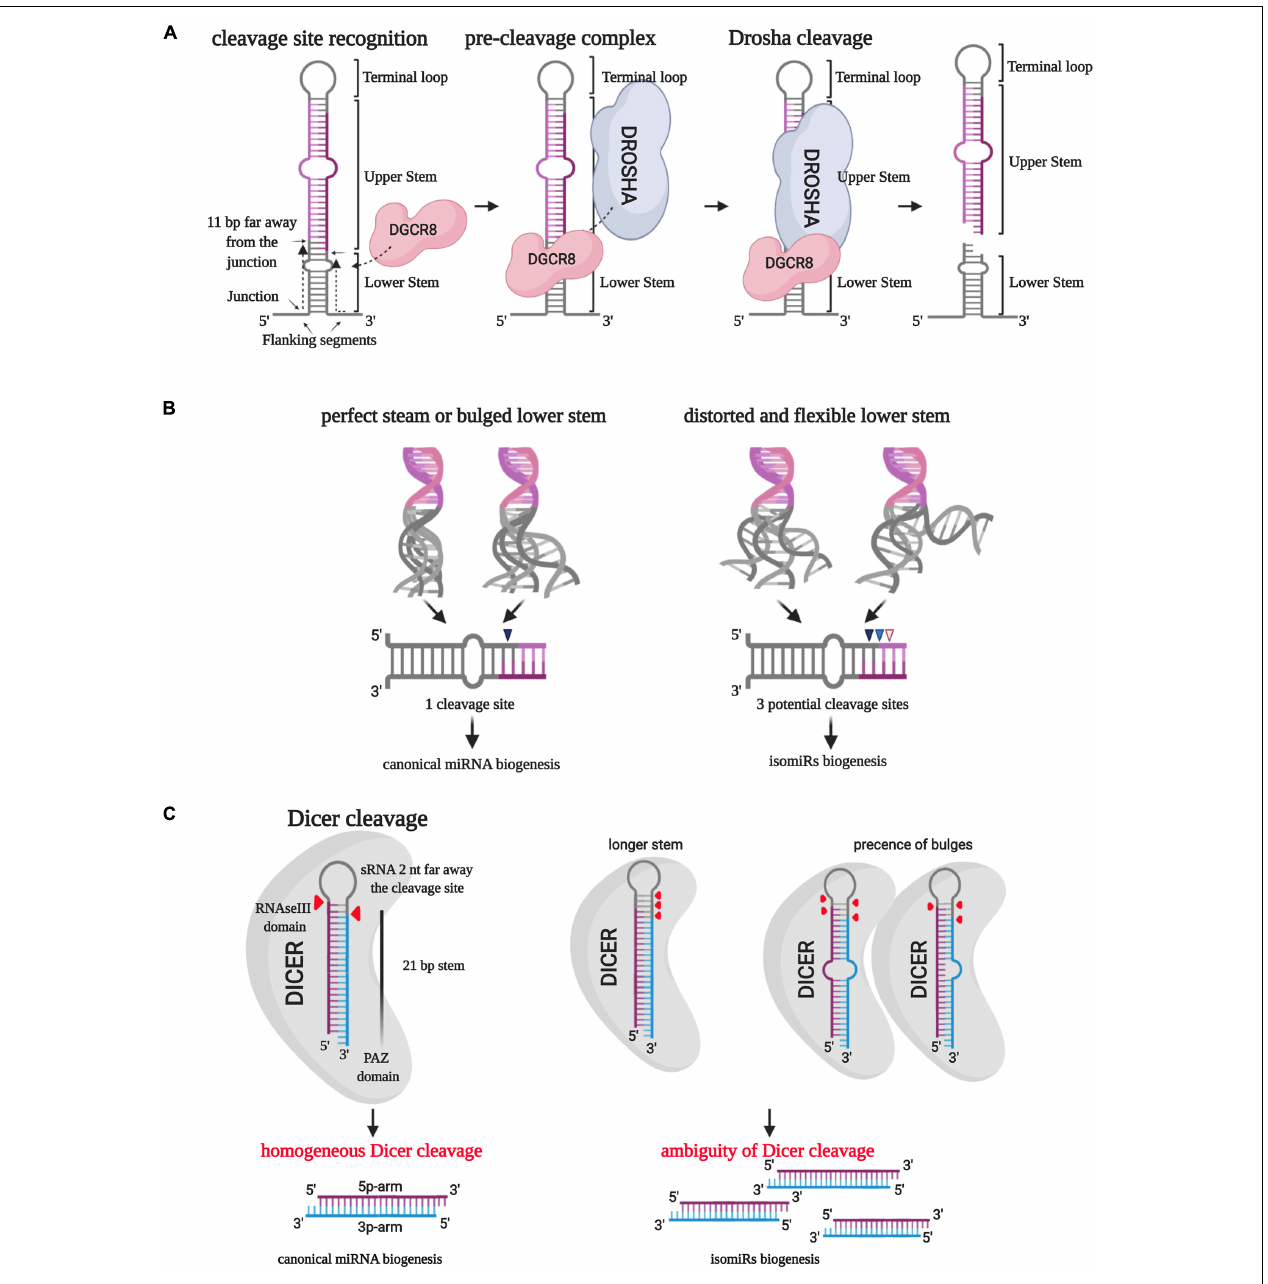
FIGURE 2 | IsomiR biogenesis. (A) The RNAse III DROSHA, aided by DGCR8, processes pri-miRNA in the nucleus and produces the first cut in correspondence of the 5 (cid:48) end of the 5p arm and 3 (cid:48) end of the 3p arm. DGCR8 acts as a molecular meter and identifies the cleavage site 11 bp far away from the junction point between the lower stem and the basal unpaired sequences. (B) The secondary structure of the lower stem of pri-miRNA affects the DROSHA cleavage precision: a perfect or bulged lower stem leads to a homogeneous cleavage site in more than 97% of the cases. On the contrary, a distorted and flexible lower stem creates three potential cleavage sites. (C) The RNase III DICER processes the short hairpin RNA (shRNA) by eliminating the terminal loop and forming a double-strand miRNA/miRNA*. Different lengths and the presence of bulges can affect the PAZ domain-mediated “measurement” of the lower stem leading to the selection of multiple cleavage